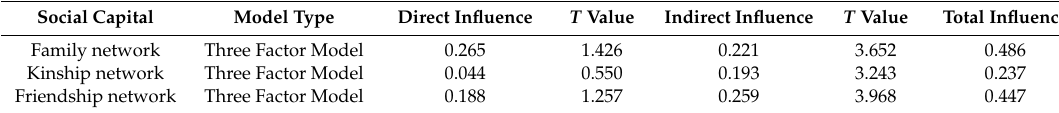
Table 2. Influence without consideration of socioeconomic status.